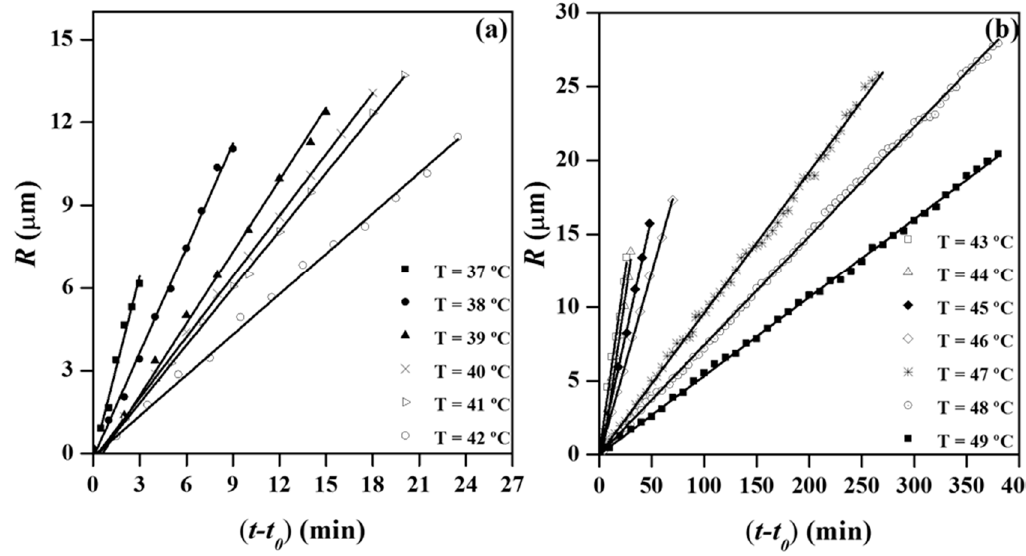
Figure 13. Variation of the spherulitic radius with crystallization time for temperatures between 37 °C and 42 °C ( a ) and 43 °C and 49 °C ( b ).